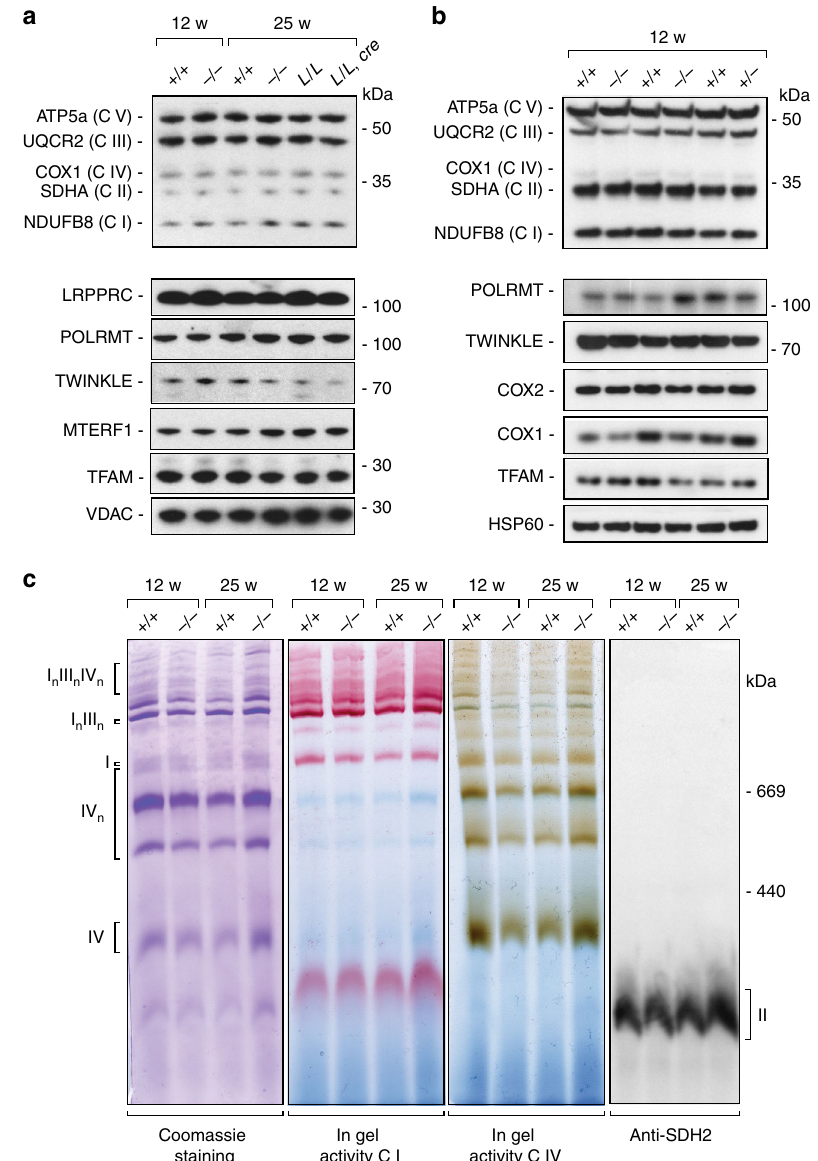
Fig. 8 Protein and respiratory complexes steady-state levels in Mgme1 knockout mice. a Western blot analysis of steady-state levels of respiratory chain complex subunits and diverse mitochondrial proteins in heart mitochondrial extracts from 12 and 25-week-old control ( + / + ) and Mgme1 knockout mice ( − / − ) mice and heart from control ( L/L ) and Mgme1 tissue-speci fi c knockout mice ( L/L, cre ). b Analysis performed as in ( a ) using liver mitochondria isolated from control ( + / + ), Mgme1 heterozygous ( + / − ), and Mgme1 knockout mice ( − / − ). c BN-PAGE analysis of Mgme1 knockout ( − / − ) and wild- type ( + / + ) heart mitochondria. Left panel, coomassie staining. Middle pannels, in-gel enzyme activities of complexes I and IV. Right panel, western blot analysis of steady-state levels of respiratory chain complex II visualized by immunostaining against SDH2 subunit. I n III n and I n III n IV n : respiratory chain